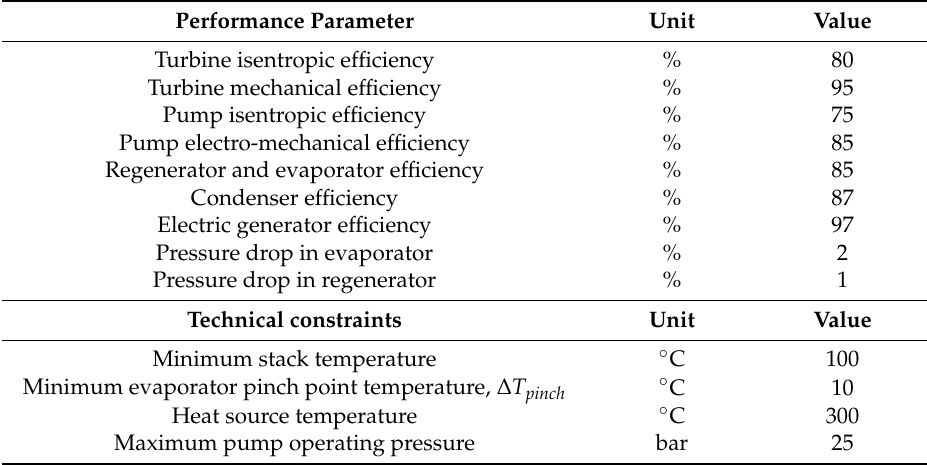
Table 5. Performance parameters and technical constraints in the ORC